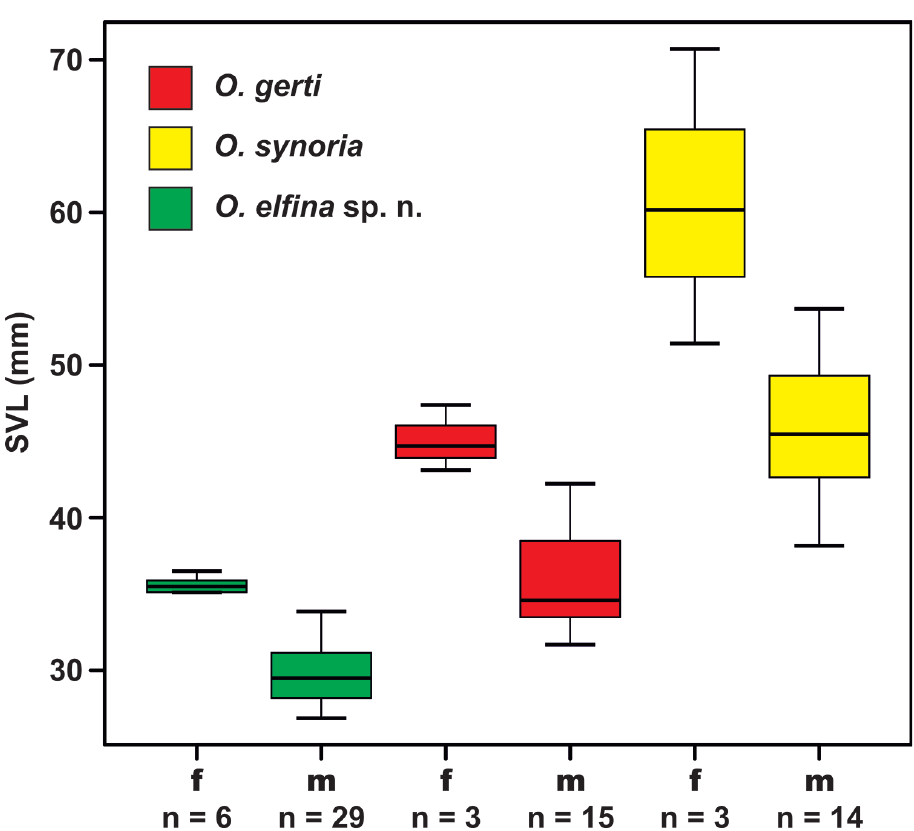
Figure 3. Boxplots of SVL showing body size variation among adult Ophryophryne males and females from the Langbian Plateau. Horizontal lines within each box represent the median, and boxes encompass the 75 th and 25 th quartiles. Color of boxes/ Ophryophryne species corresponds to icon colors on Figs 1,